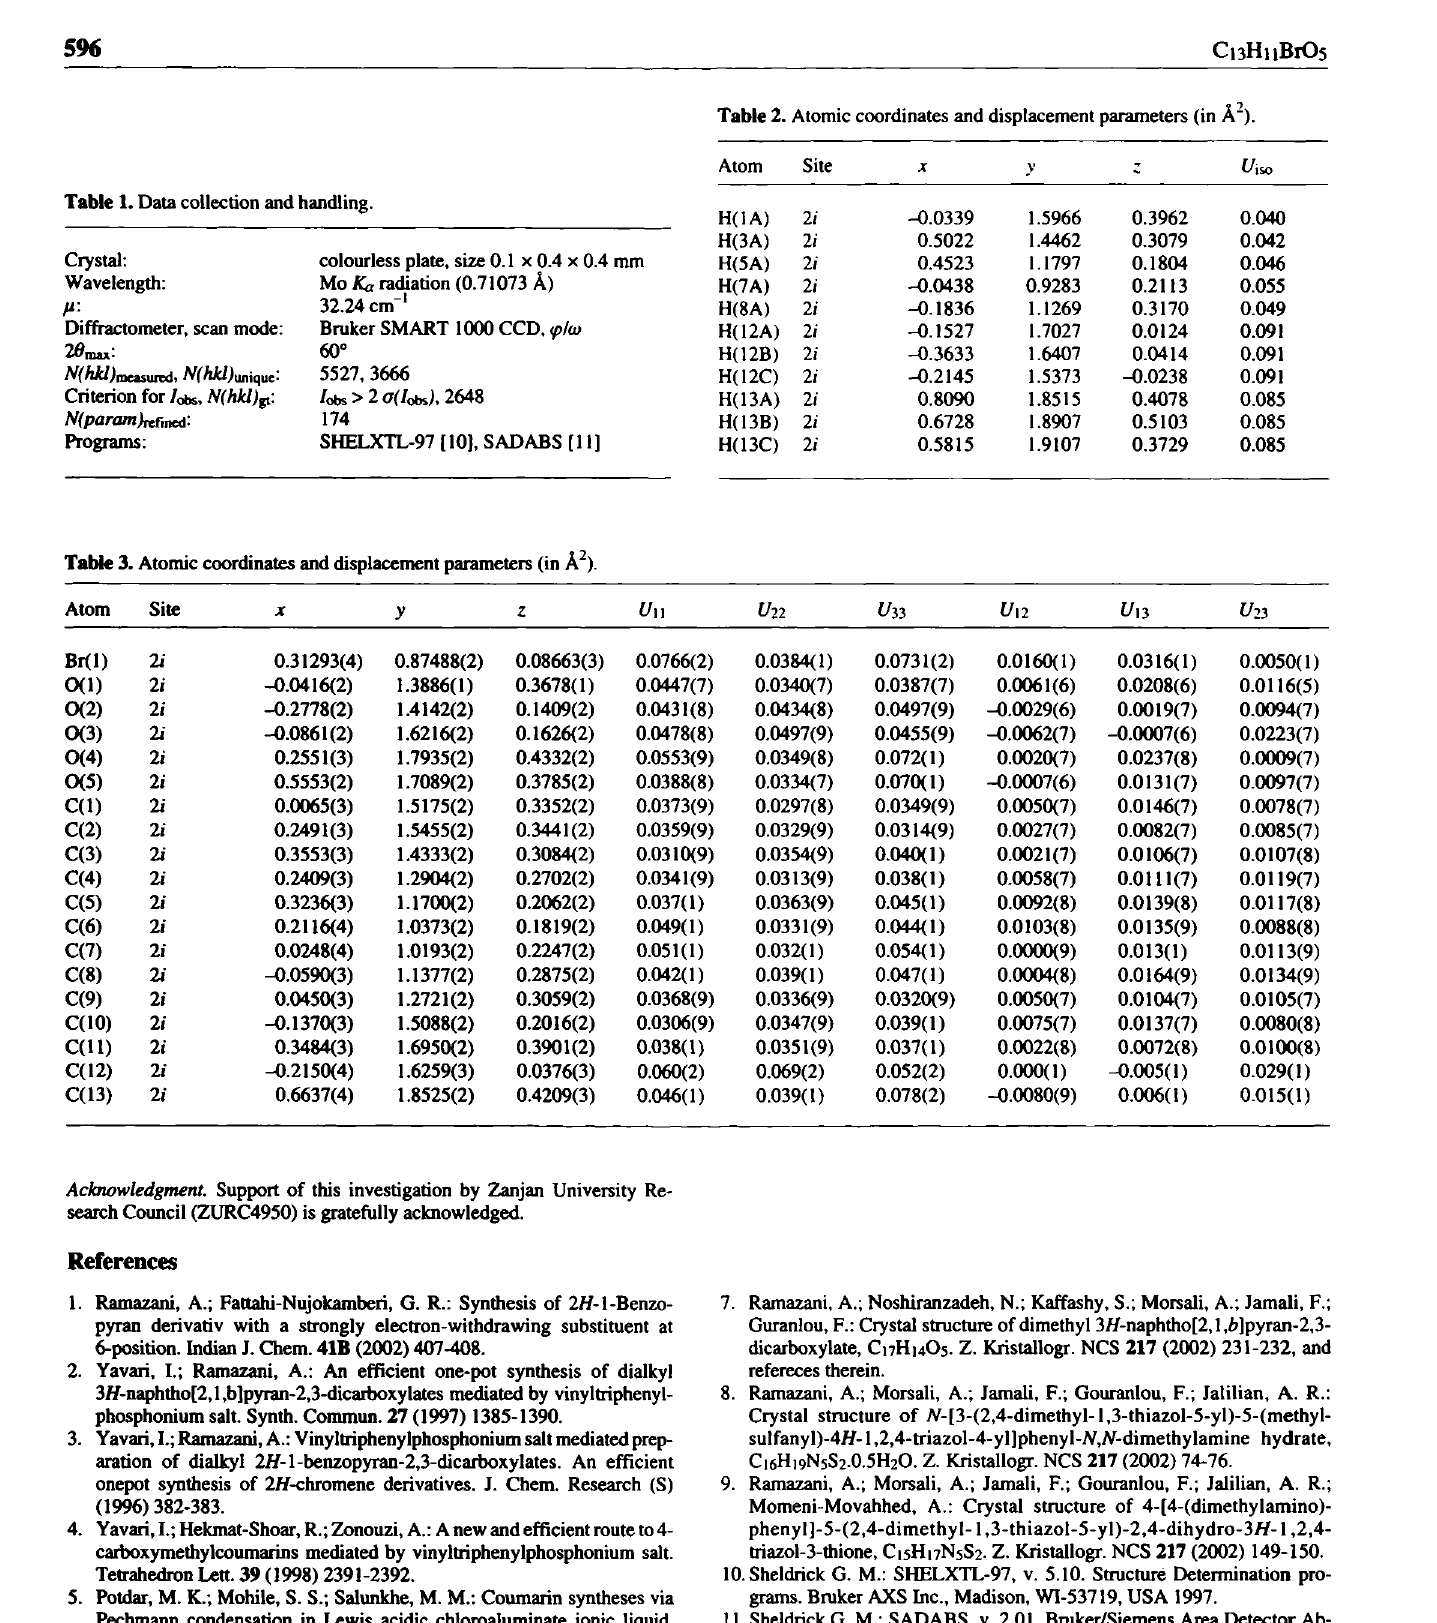
Table 2. Atomic coordinates and displacement parameters (in À 2 ).